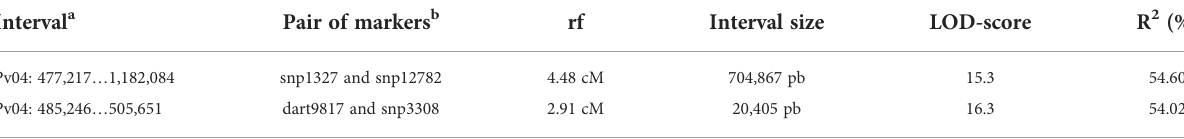
TABLE 2 SNP and DArT markers fl anking the major locus (Co-Realce) controlling anthracnose resistance in the Andean common bean cultivar BRSMG Realce, recombination frequency between the pair of markers fl anking Co-Realce , interval size of the Co-Realce region, LOD-score and percentage of phenotypic variation explained by major locus Co-Realce